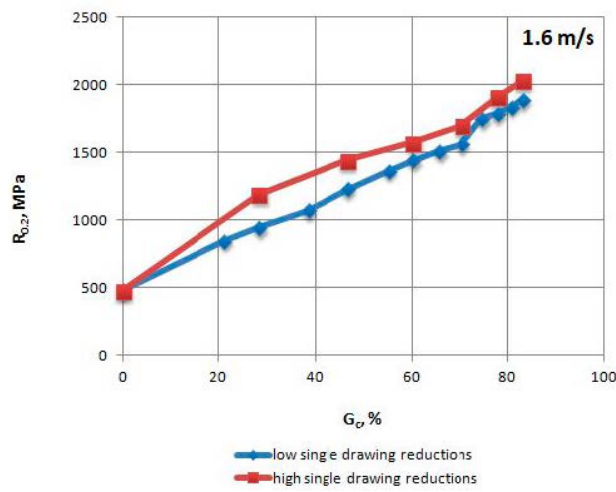
Figure 3. Change of the proof yield strength R 0.2 of TRIP steel wires for variants with low and high single drawing reductions, at a speed of 1.6 m/s, as the total drawing reduction function.